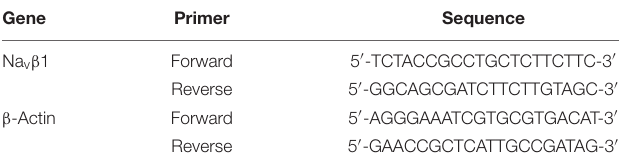
TABLE 1 | Specific primer